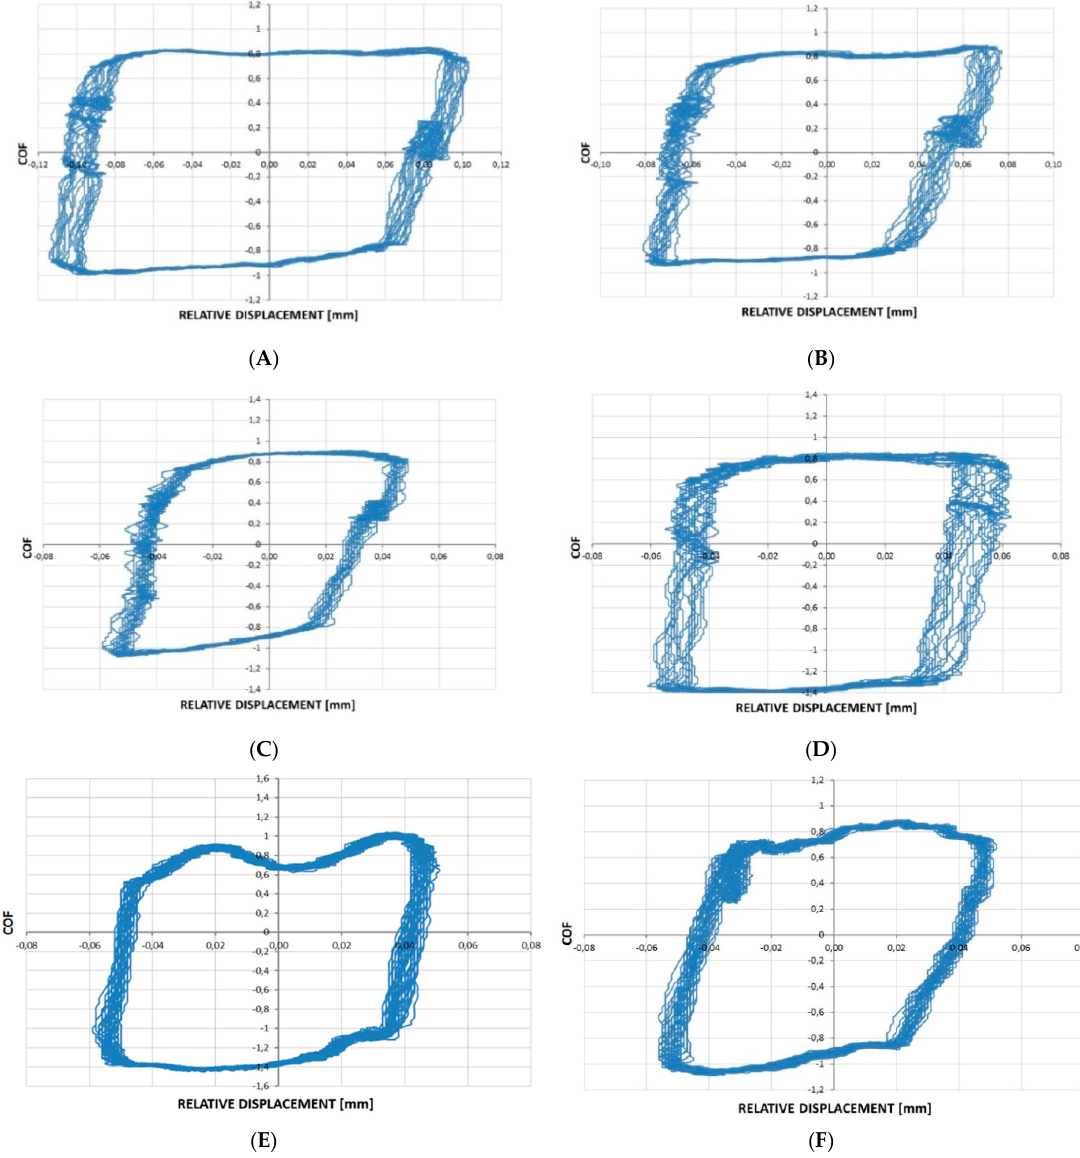
Figure 8. Fretting loops for sliding pair with lapped disc L after tests: ( A ); s = 0.2 mm, P = 45 N, f = 20 Hz s = 0.2 mm, P = 45 N, f = 20 Hz, ( B ); s = 0.15 mm, P = 45 N, f = 20 Hz, ( C ); s = 0.1 mm, P = 45 N, f = f = 20 Hz, s = 0.2 mm, P = 45 N, f = 20 Hz; ( B ) s = 0.15 mm, P = 45 N, f = 20 Hz; ( C ) s = 0.1 mm, P = 45 N, 20 Hz, ( D ); s = 0.1 mm, P = 15 N, f = 20 Hz, ( E ); s = 0.1 mm, P = 15 N, f = 50 Hz and ( F ); s = 0.1 mm, P = f = 20 Hz; ( D ) s = 0.1 mm, P = 15 N, f = 20 Hz; ( E ) s = 0.1 mm, P = 15 N, f = 50 Hz and ( F ) s = 0.1